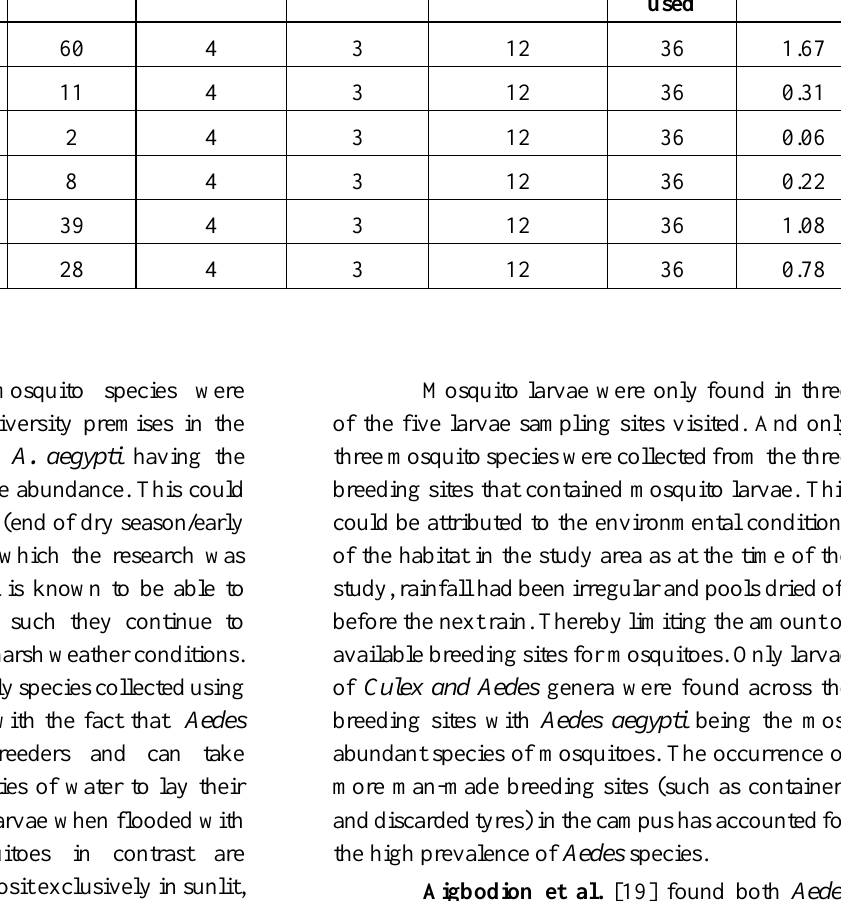
Total hours of collection per day